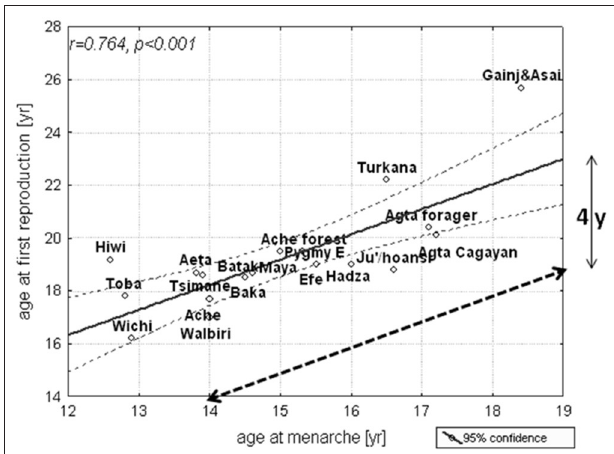
FIGURE 4 | Age at menarche and first birth among some natural fertility societies; mean and 95% confidence limits. The dashed line is the age at menarche when plotted against the age at first reproduction [reproduced with permission from Hochberg et al. (